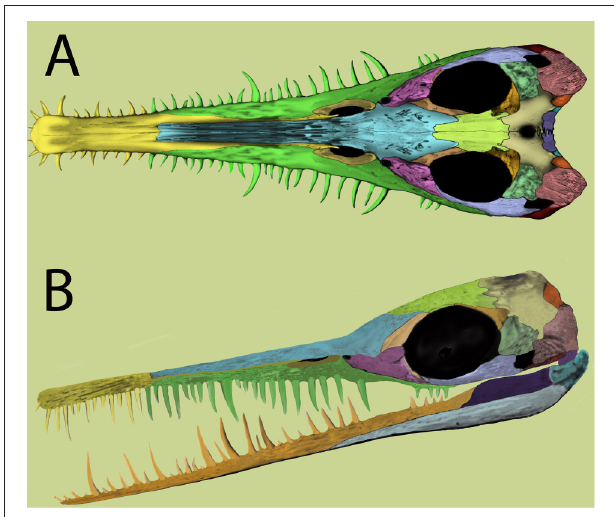
FIGURE 2 | Mesosaur skull reconstruction based on recent evidence. (A) , dorsal view; (B) , lateral view. Modified from Piñeiro et al.